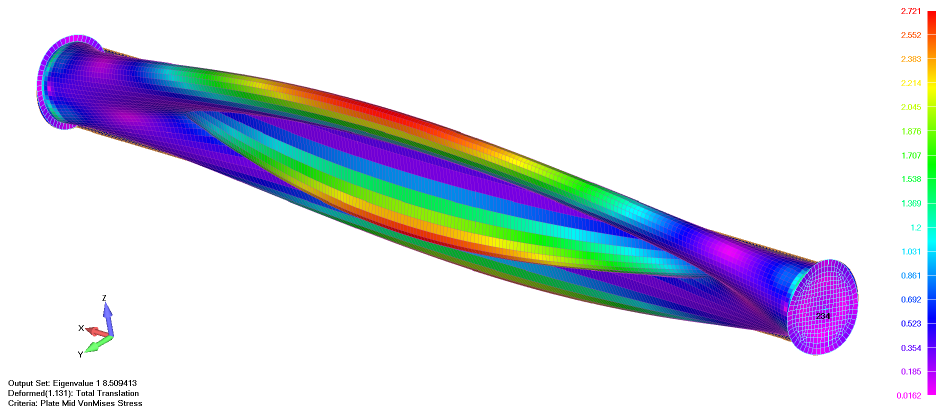
Figure 5. Buckling mode of the battery cylinder pod.